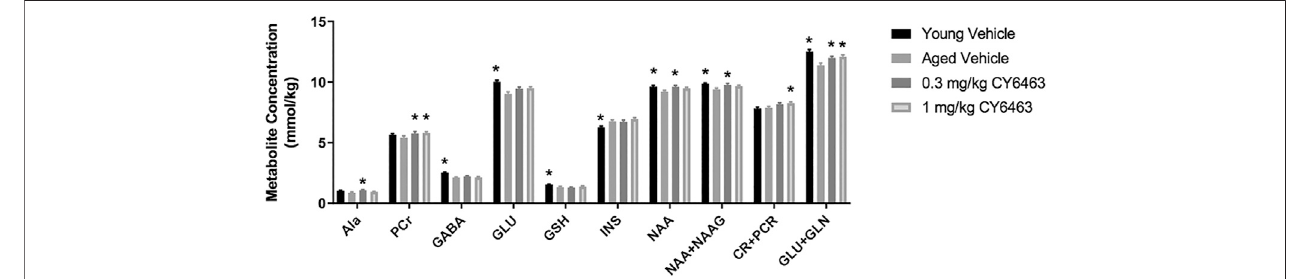
FIGURE 8 | Hippocampal 1H-MRS. Young vehicle-treated and aged CY6463-treated rats vs. aged vehicle-treated rats (* p < 0.05). All data are expressed as mean ± SEM. Abbreviations for metabolites are as follows: Ala – alanine, PCr – phosphocreatine, GABA – gammaaminobutyric acid, Glc – glucose, GSH – glutathione, INS – myo-inositol, NAA – N-acetyl aspartate, N-acetyl aspartyl glutamate –